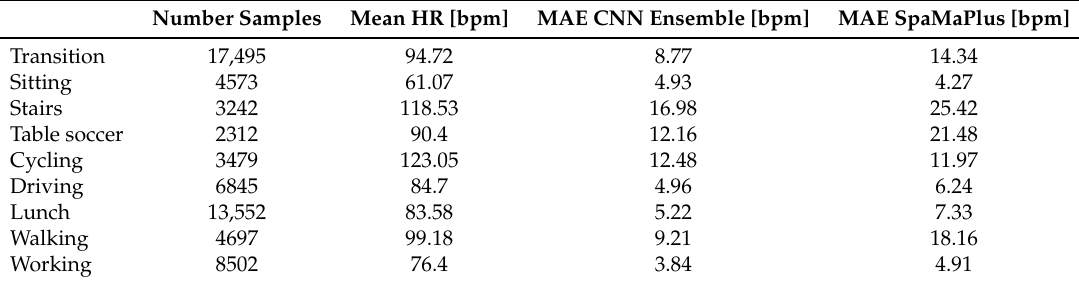
Table 11. PPG-DaLiA : analysis of the dataset (number of samples and mean heart rate) and achieved results (with the best performing deep learning and classical approach) for each activity included in the data collection